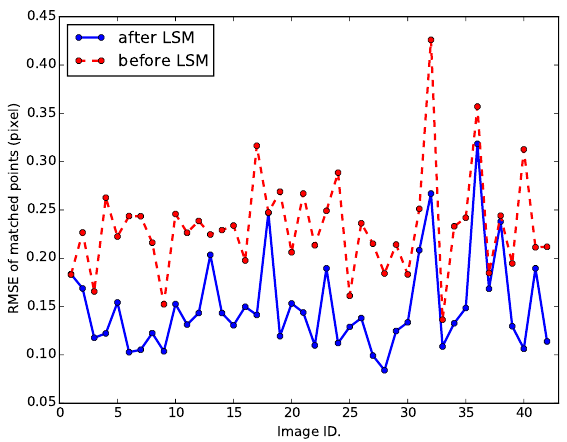
Figure 9. Root mean square biases of matched points before and after least squares match (LSM)